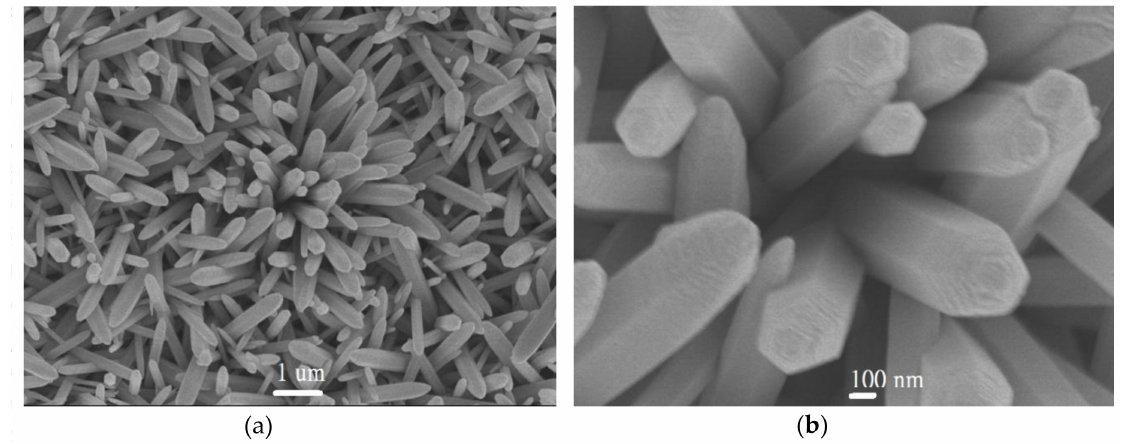
Figure 1. XRD patterns of ( a ) polyetheretherketone (PEEK) sample and ( b ) ZnO nanorods / PEEK sample.